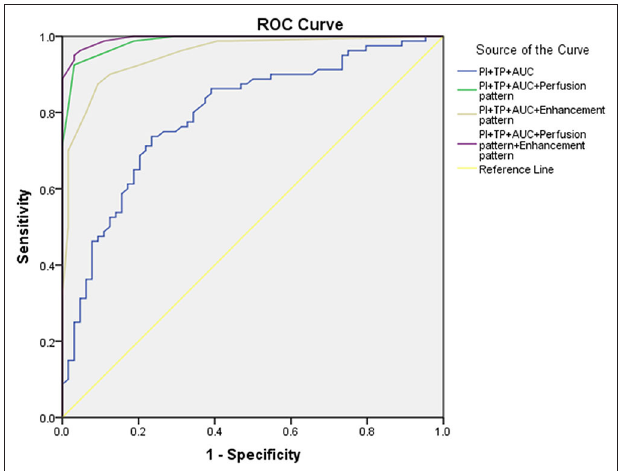
FIGURE 4 | The receiver operating characteristic (ROC) curve for combination